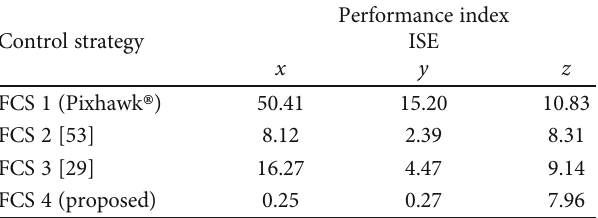
Table 5: ISE performance index analysis: fl ight scenario 2. Control